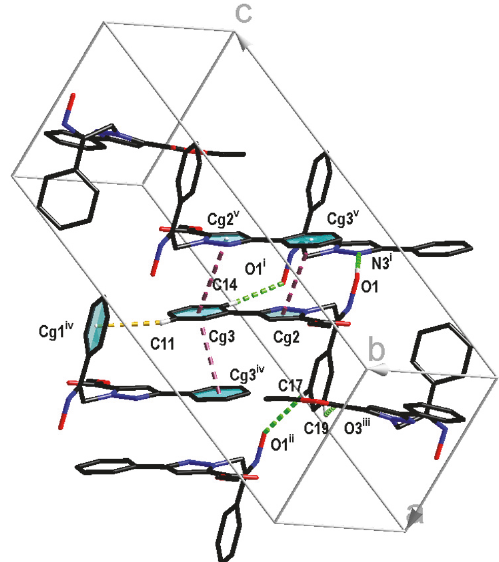
Figure 2: The intermolecular hydrogen-bonding interactions (green-dashed lines), 𝜋 - 𝜋 stacking interactions (carmine-dashed lines), and C-H ⋅⋅⋅𝜋 interactions (orange-dashed lines) in title compound. Uncorrelated hydrogen atoms are omitted for clarity. H-Atoms on C11, C14, C17, and C19 are H11, H14, H17, and H19,